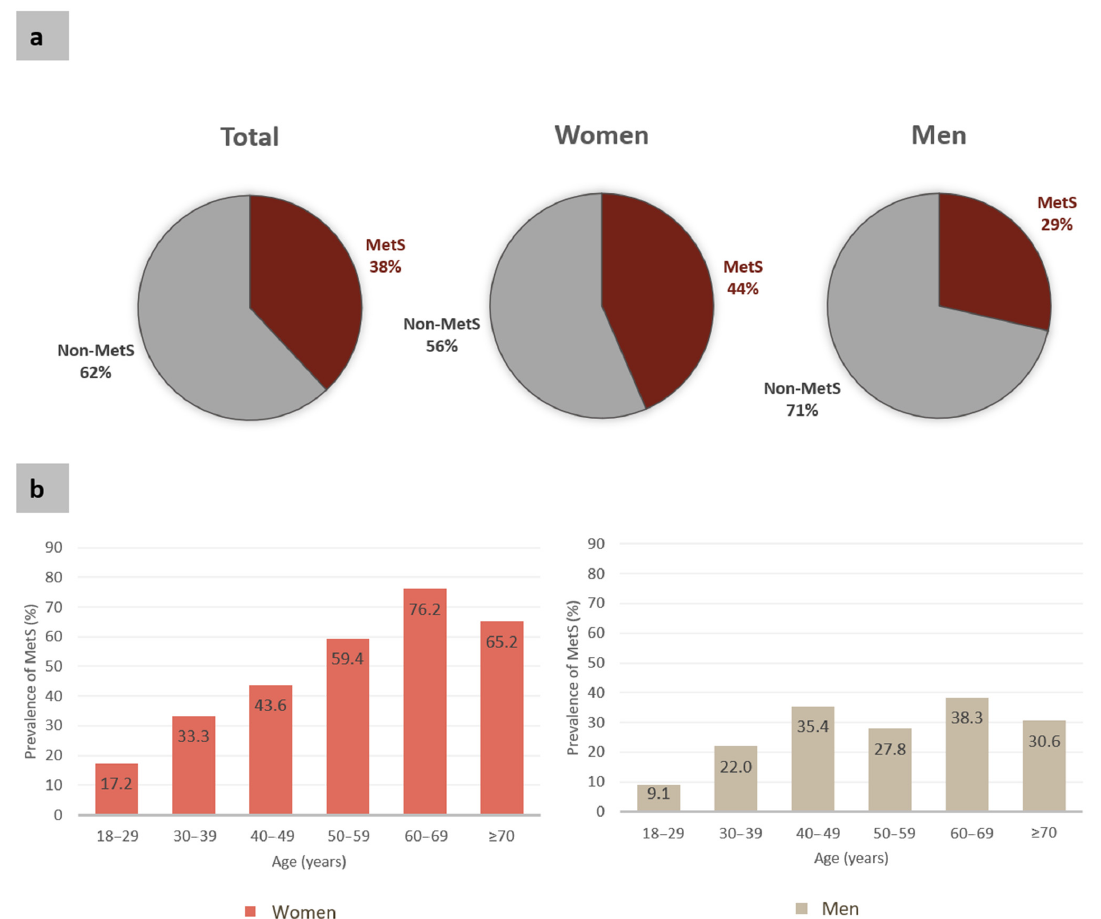
Figure 3. Prevalence of metabolic syndrome (MetS) for all participants, women and men ( a ) and according to the different age ranges. ( b ) Prevalence of MetS was higher among women (Fisher’s exact test, p < 0.0001).